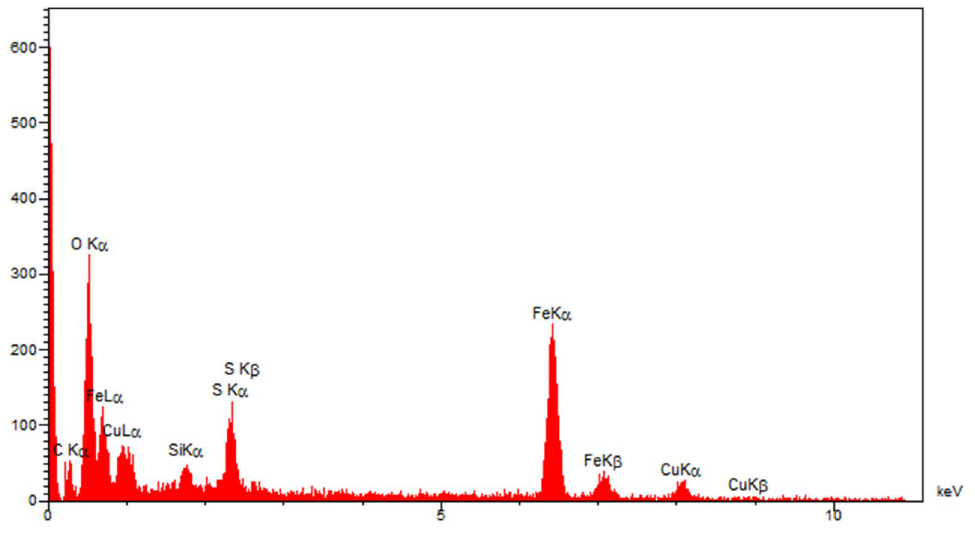
Figure 4. EDX spectrum of Fe 3 O 4 -PTMS-NAS@Cu